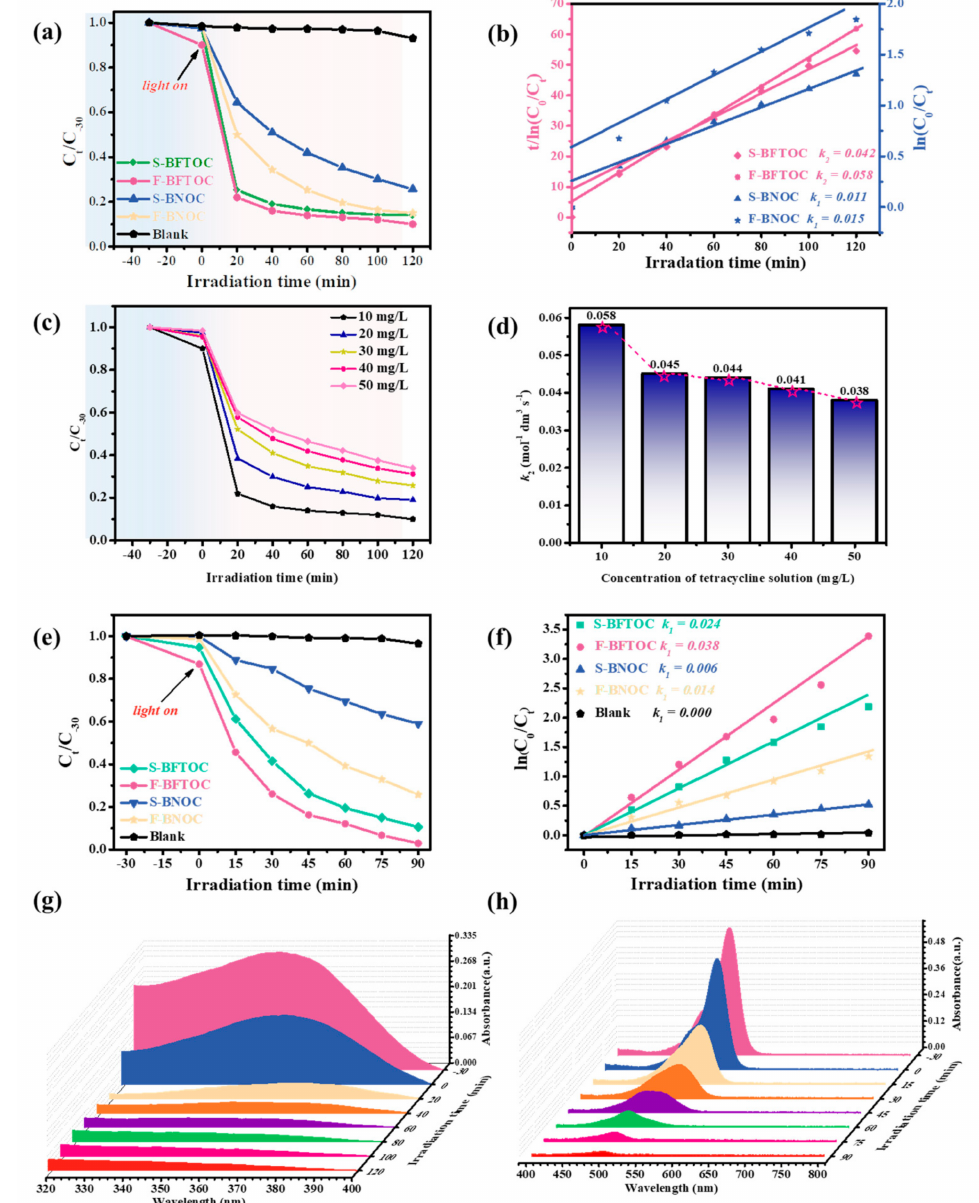
Figure 4. ( a ) Photocatalytic degradation curves of TC over different photocatalysts under visible light irradiation; ( b ) The pseudo-second-order kinetic curves of the as-prepared photocatalyst for the degradation of TC; ( c ) Photocatalytic degradation and ( d ) k 2 values of different TC concentration over F-BFTOC under visible light irradiation; ( e ) Photocatalytic degradation curves of RhB over different photocatalysts under visible light irradiation; ( f ) The pseudo-first-order kinetic curves of the as-prepared photocatalyst for the degradation of RhB; ( g , h ) Absorption spectra of TC and RhB photocatalyzed by F-BFTOC,